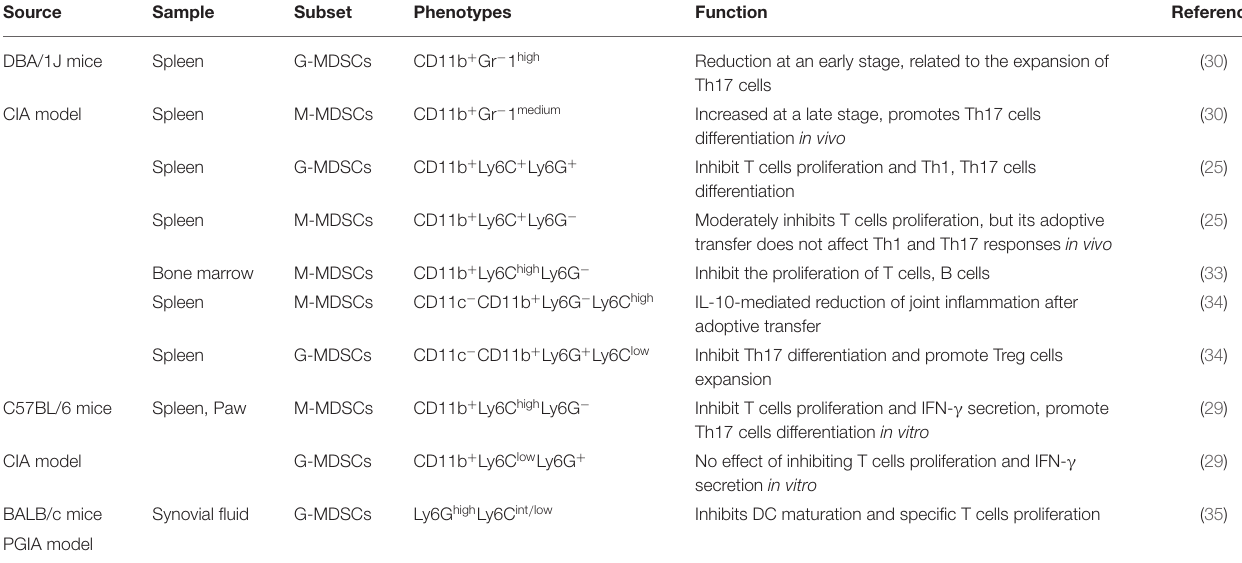
TABLE 2 | Subpopulations and phenotypes of MDSCs in animal